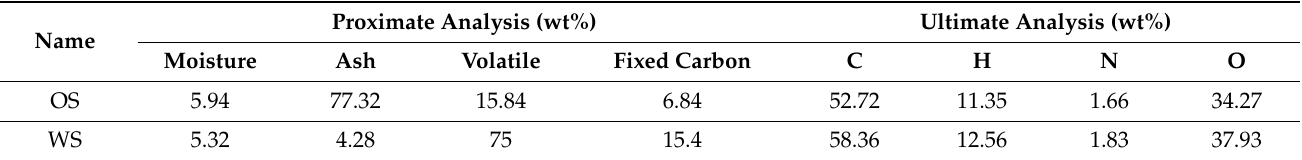
Table 1. Proximate analysis and element analysis of oily sludge and walnut